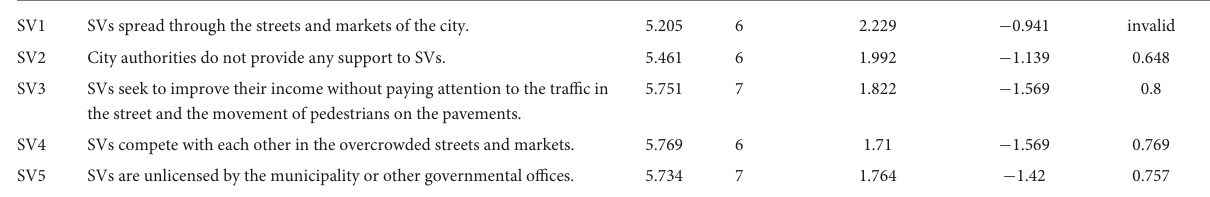
TABLE 1 Measurement properties of street vending.